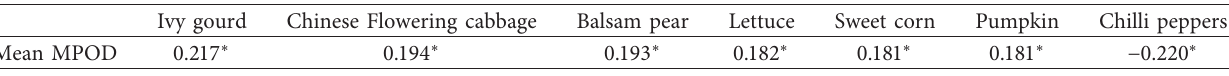
Table 7: Correlation between MPOD volume and the intake of green onions and amaranth among participants ( n � 120). Green onions Amaranth MPOD volume 0.212 ∗ − 0.283 ∗ ∗ Correlation is significant at the 0.05 level (2-tailed). Table 8: Mean MPOD for the participant with low ( < 3 eggs/week) and moderate egg consumption ( ≥ 3 eggs/week) in the three age groups ( < 50 years, 50–59 years and ≥ 60 years).